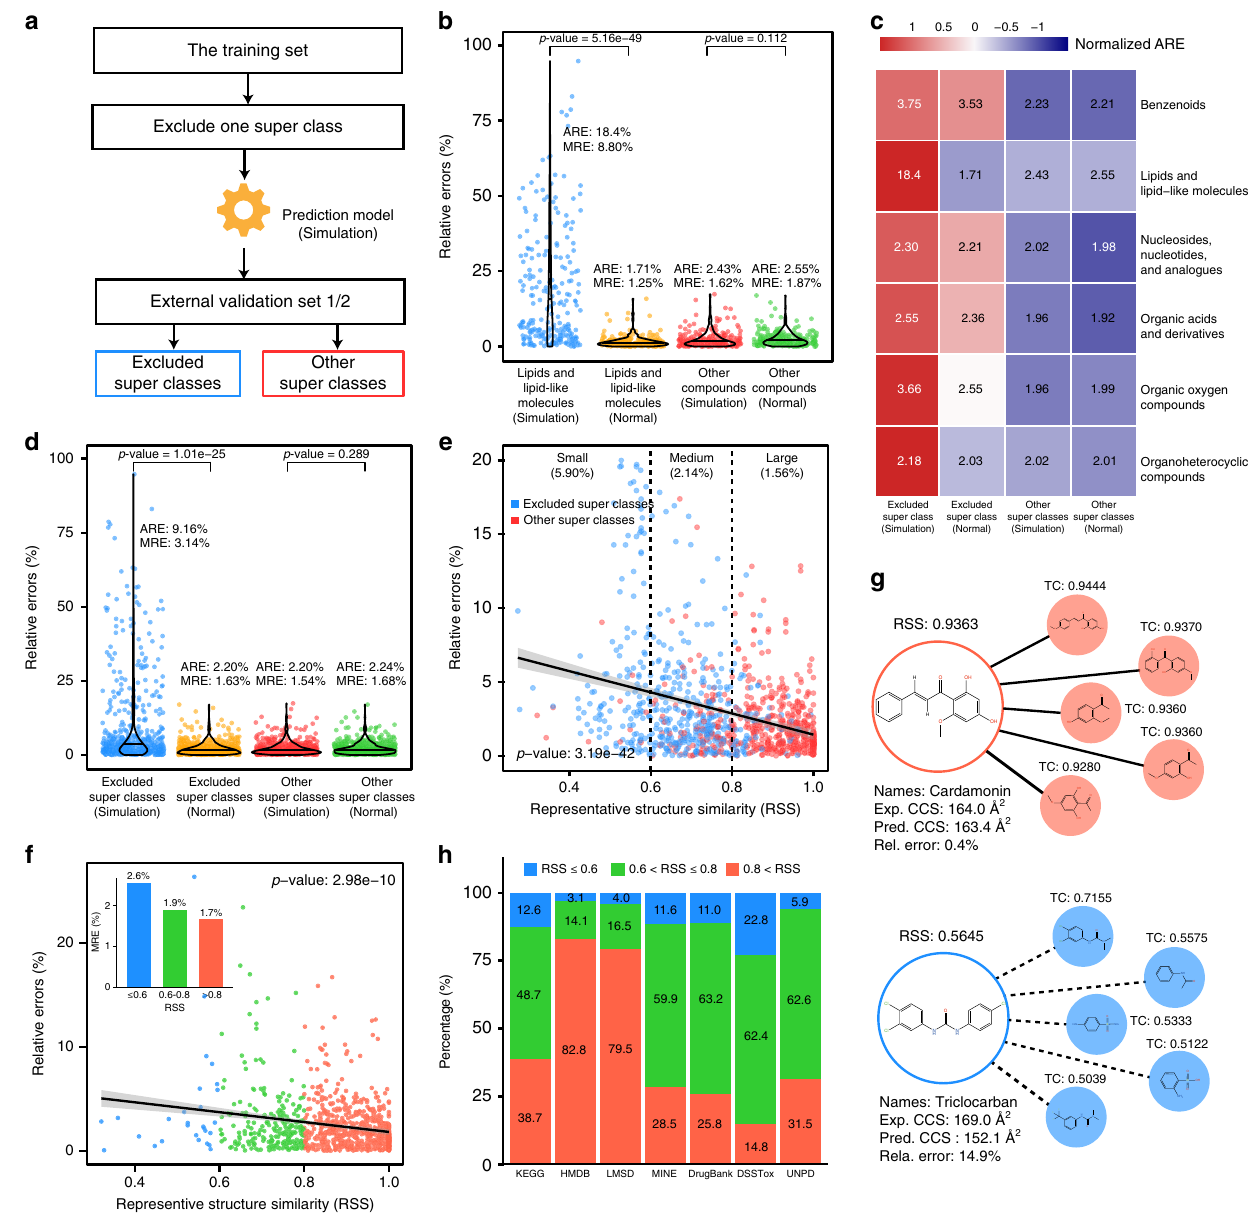
Fig. 3 Representative structure similarity (RSS) and CCS prediction accuracy. a The simulation work fl ow for investigating the structural similarity and prediction accuracy of CCS values; b comparison of CCS prediction accuracy between before and after excluding lipid and lipid-like molecules from the training set; the abbreviations “ ARE ” and “ MRE ” represent average relative error and median relative error, respectively; p- values determined by two-sided Wilcoxon rank-sum test; c , d comparison of CCS prediction accuracy between before and after excluding one super class from the training set; p -value determined by two-sided Wilcoxon rank-sum test; e correlation between the RSS scores and the relative errors of CCS prediction; the error bands represent 95% con fi dence interval; p -value determined by linear regression; f correlation of RSS scores and prediction errors in validation sets; the insert bar plot displays MREs for different RSS groups; the error bands represent 95% con fi dence interval; p -value determined by linear regression; g two compound examples for RSS and CCS prediction accuracy; The abbreviation “ TC ” represents tanimoto coef fi cient; h distribution of RSS scores in seven common compound databases. Source data are provided as a Source Data fi